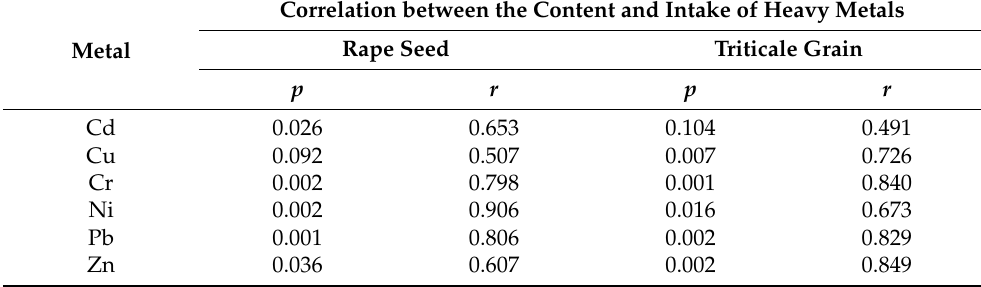
Table 9. Correlation between the content and uptake of heavy metals by test